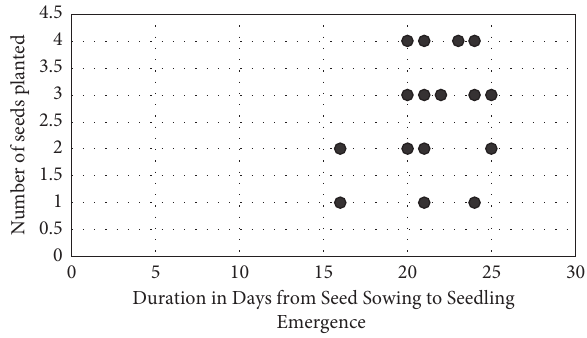
Figure 5: A plot of the distribution of number of seeds germinating against the number of days elapsed since seed sowing for 95 seeds. Size of blob corresponds to the number of seeds germinating with 1 and 4 being the minimum and maximum, respectively.